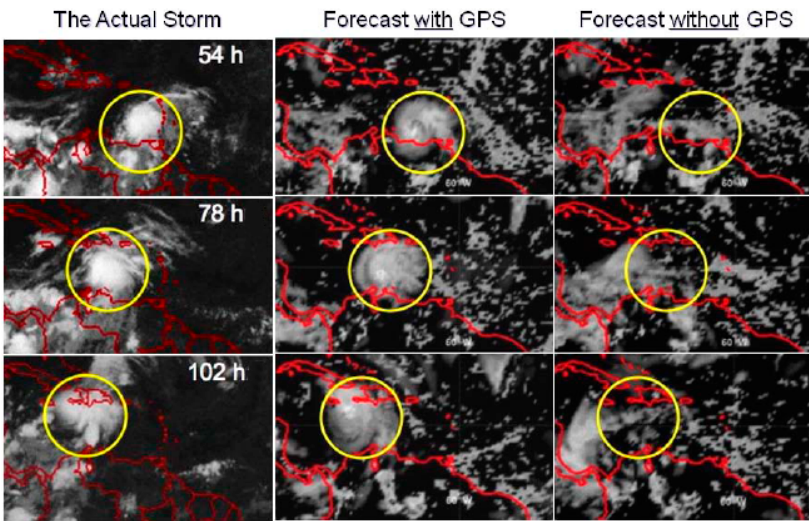
Figure 11. Left column shows the image of Ernesto’s genesis taken by a satellite after 54, 78, and 102 h; the middle column shows the model result with RO data; the right column shows the model results without the RO data. Ernesto’s genesis is predicted successfully after assimilating the RO observation [60].